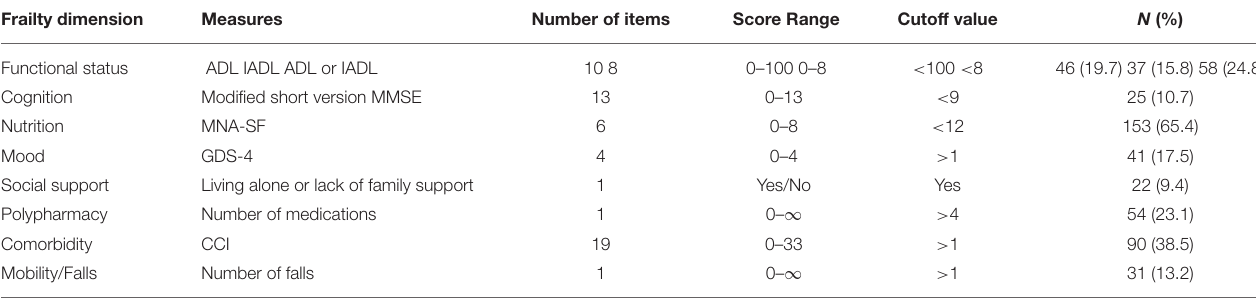
TABLE 2 | Defect distribution in multiple frailty dimensions of older cancer patients ( N = 234).